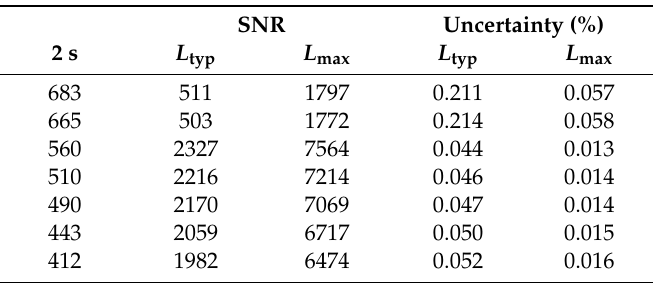
Table 4. Signal to noise ratio at 2 s acquisition duration for average ( L typ ) and maximum ( L max ) levels of radiance recorded at BOUSSOLE and associated